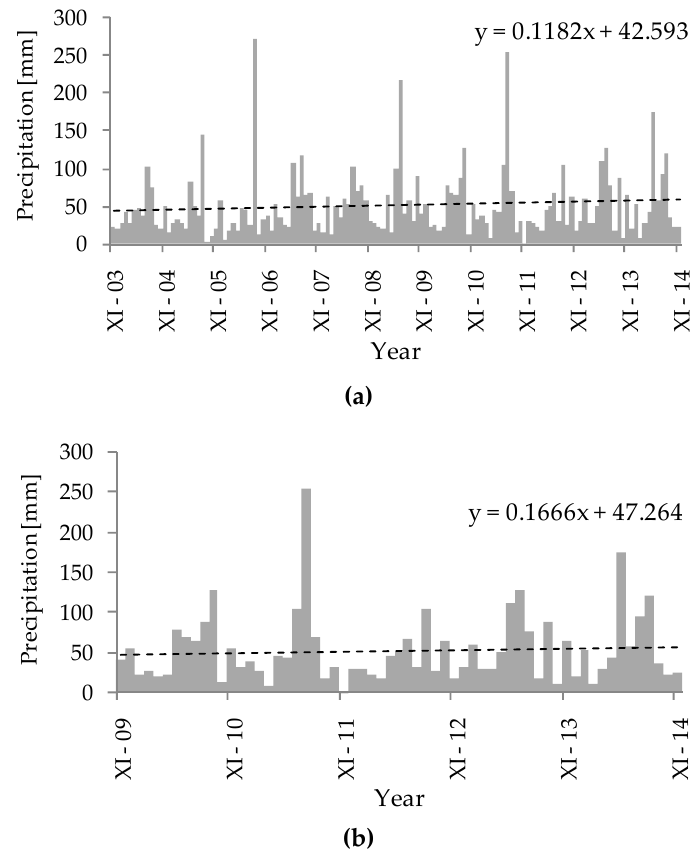
Figure 2. Monthly precipitation totals for two periods: ( a ) 2004–2014; ( b ) 2010–2014. The dashed line represents the trend line of changes in precipitation over time. represents the trend line of changes in precipitation over